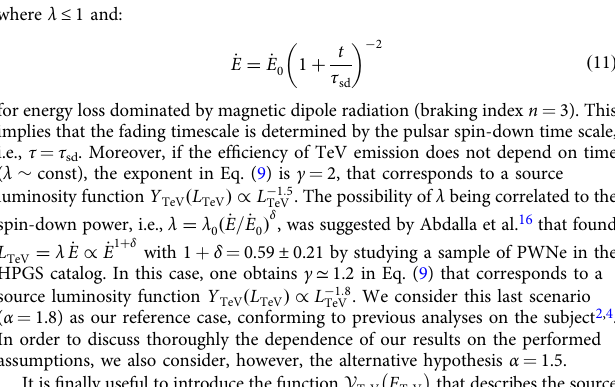
Consistency among HGPS and Fermi-LAT catalogs . The adopted range for the fl ux ratio parameter R Φ can be further validated by comparing the predicted source fl ux distribution in the GeV domain with the 4FGL-DR2 catalog (Fig. 4). It should be remarked that, while PWNe provides the prominent contribution of the